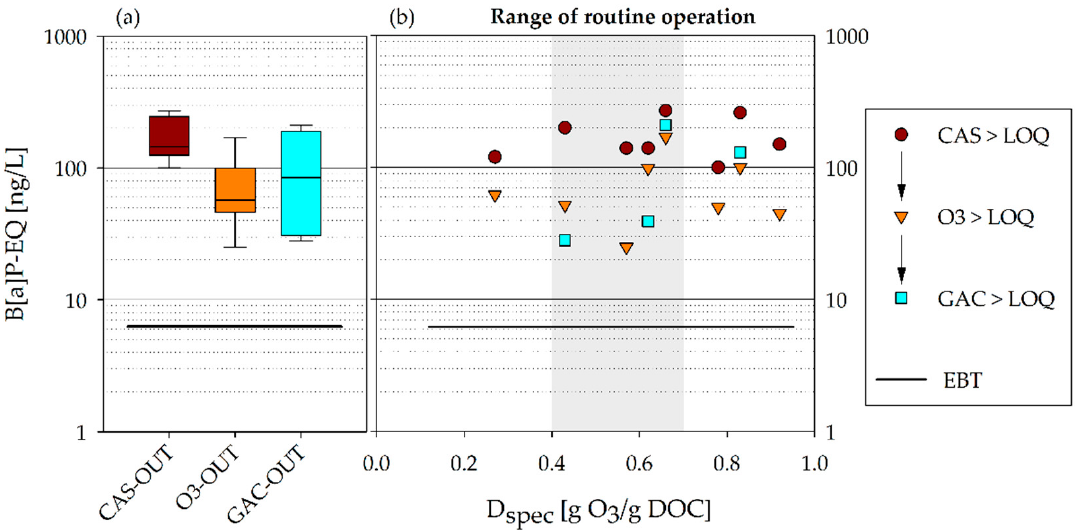
Figure 6. ( a ) Boxplot showing the range of benzo[a]pyrene equivalents over all campaigns along the multibarrier system; ( b ) B[a]P-EQ along the multibarrier system for each sampling campaign.